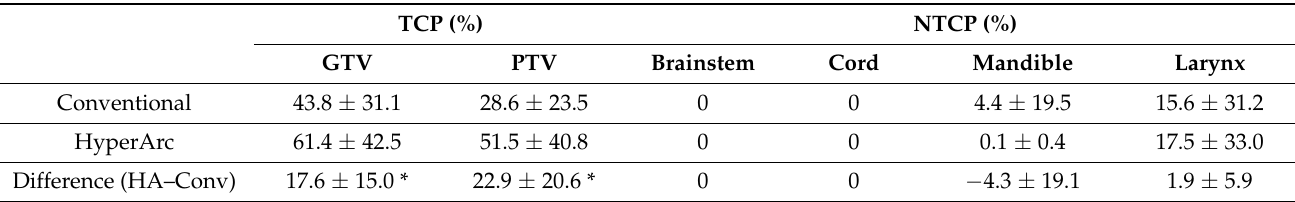
Table 4. The calculated tumor control probability (TCP) and normal tissue complication probability (NTCP) for the conventional and HyperArc plans (given as mean ± standard